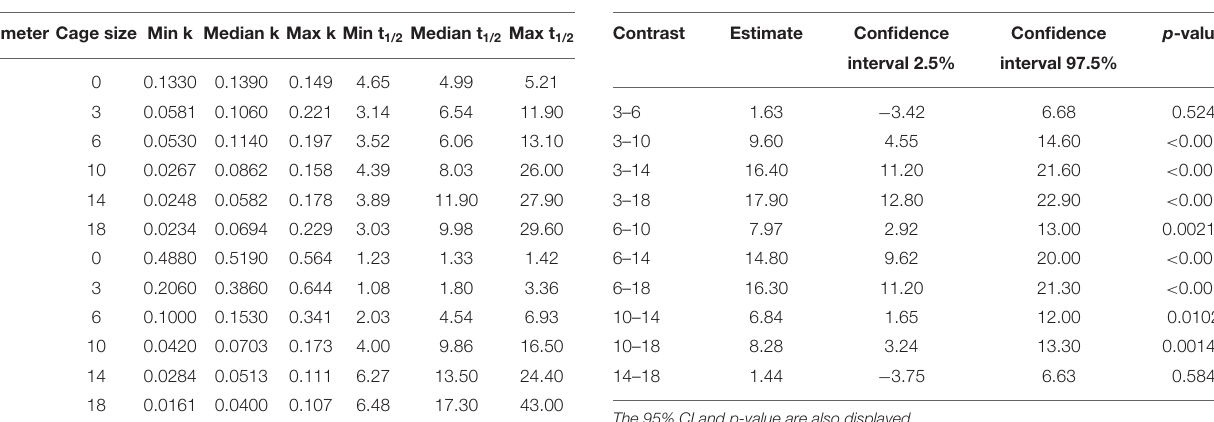
TABLE 5 | Maxima, minima, and median values of k13 and k31, the rate constants of drug movement into and out of the tissue cages, by cage size.